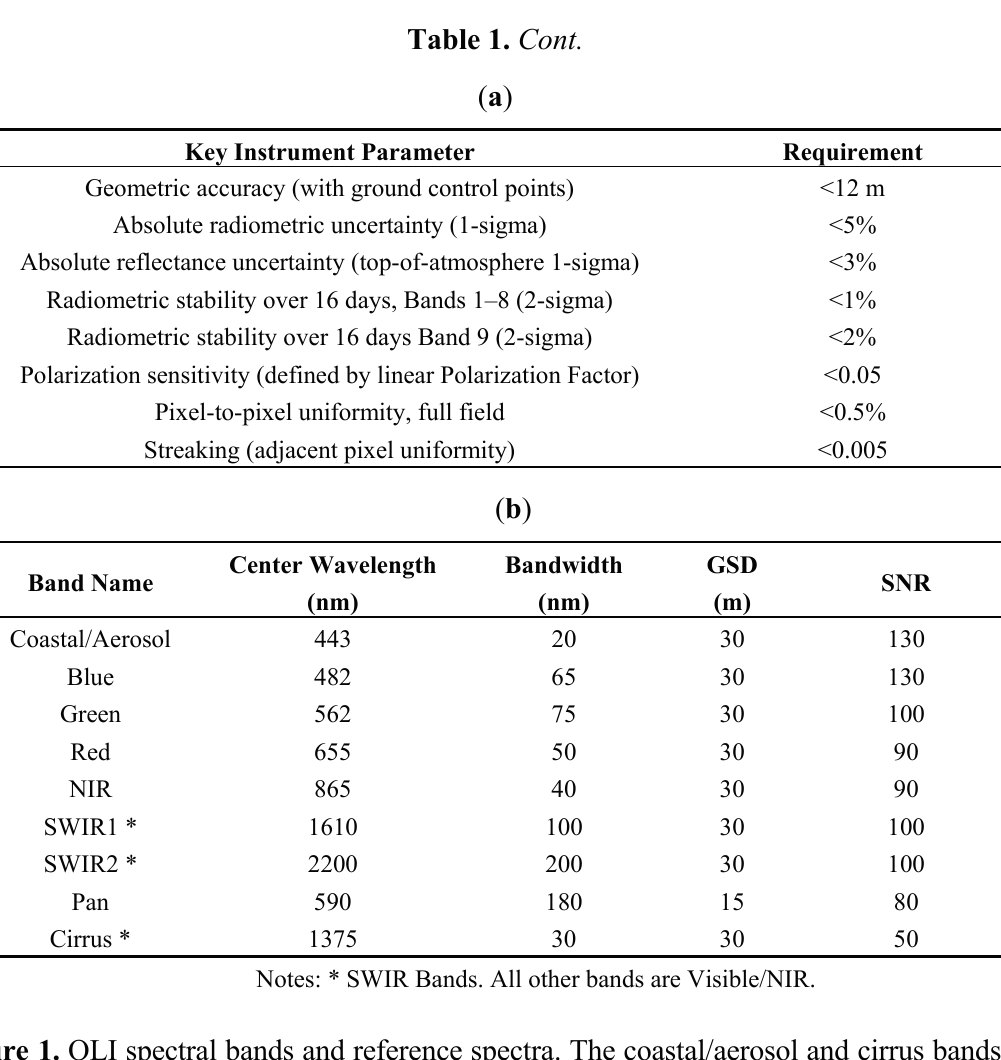
Figure 1. OLI spectral bands and reference spectra. The coastal/aerosol and cirrus bands are new for OLI. The NIR and PAN bands are narrower than Landsat-7 and shifted to improve contrast. All other bandpasses are similar to the heritage Landsat-4, -5 and -7